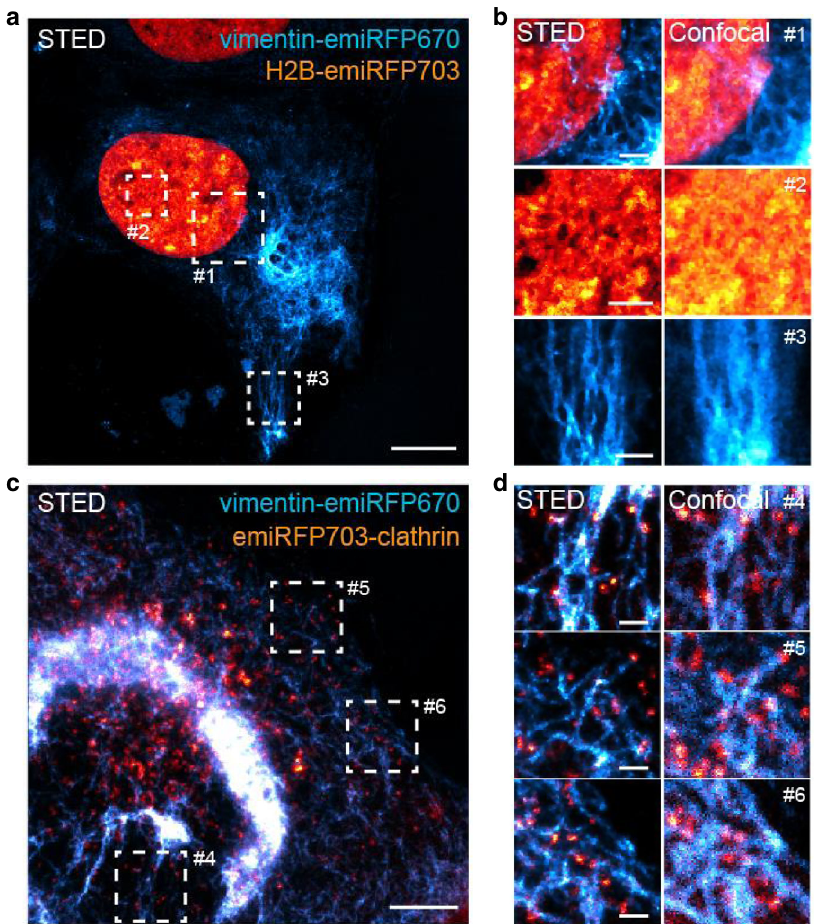
Fig. 6 Two-color STED imaging of emiRFP670 and miRFP703 fusions. a STED image of a live U2OS cell expressing vimentin-emiRFP670 (cyan) and H2B-emiRFP703 (orange). Scale bar, 10 µ m. b Three zoom-ins of the regions of interest #1 – 3 from image a . Scale bars, 2 µ m. c STED image of a live U2OS cell expressing vimentin-emiRFP670 (cyan) and emiRFP703-clathrin (orange). Scale bar, 5 µ m. d Three zoom-ins of the regions of interest #4 – 6 from image c . Scale bars, 1 µ